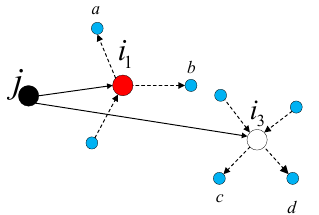
Figure 6. The second round of redistribution on the power side.